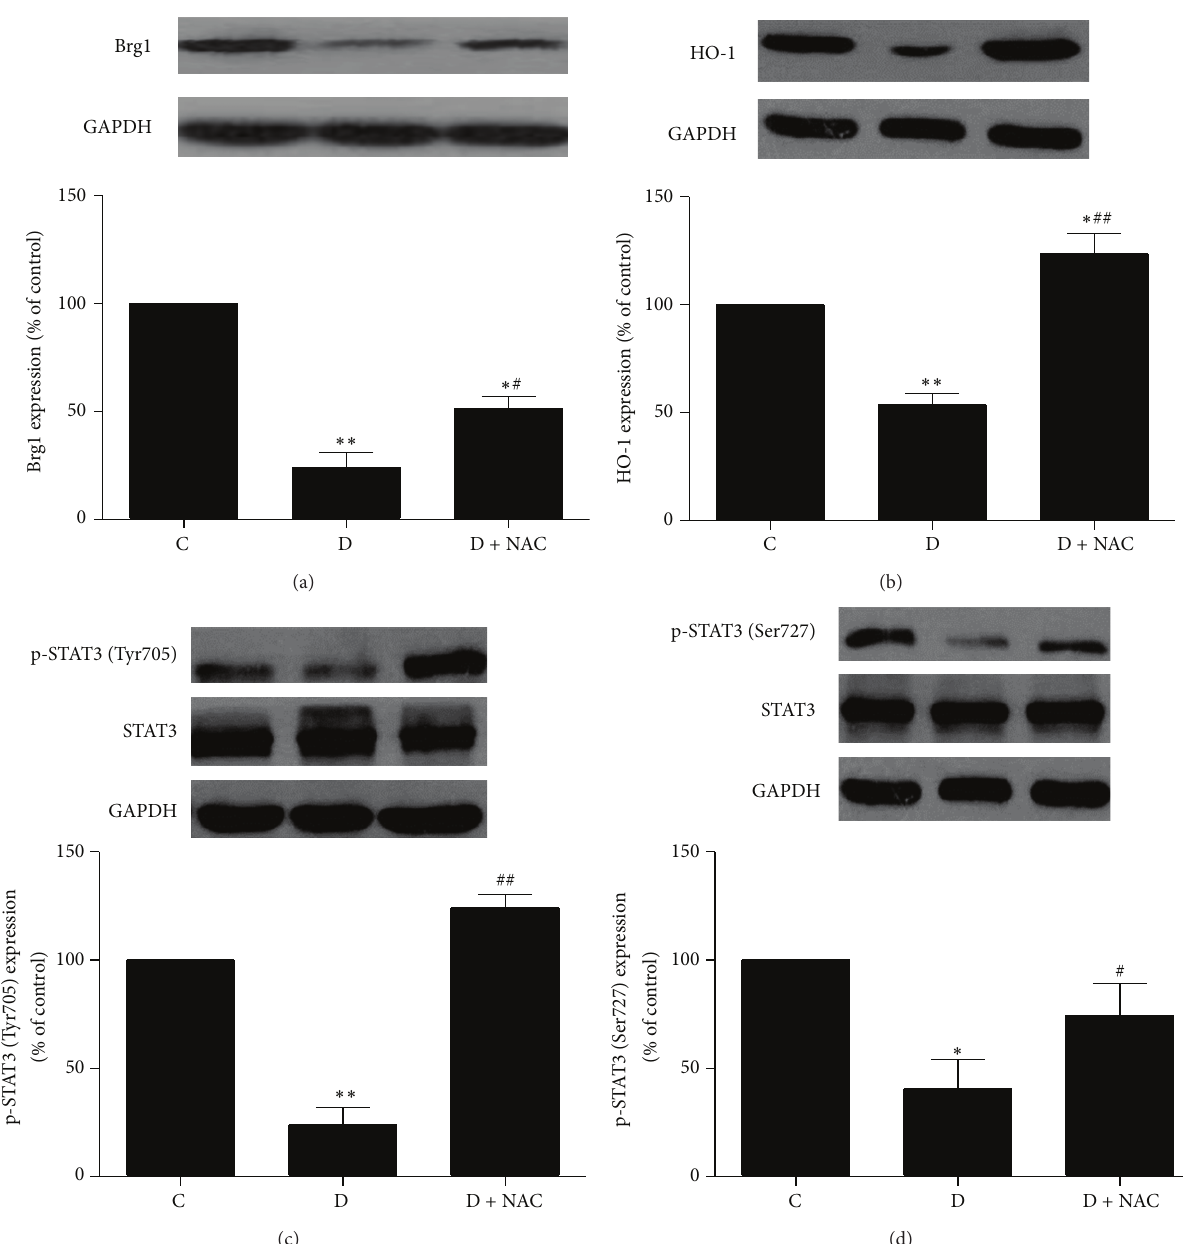
Figure 2: Effects of N-acetylcysteine (NAC) treatment on the protein expression of Brg1 (a), HO-1 (b), and p-STAT3 ((c), (d)) in myocardium. Control (C) or STZ-induced diabetic rats without treatment (D) or with NAC treatment (1.5g/kg/day, D + NAC) for 4 weeks. All values are expressed as mean ± S.E.M. 𝑛 = 6 per group. ∗ 𝑃 < 0.05 , ∗∗ 𝑃 < 0.01 versus C; # 𝑃 < 0.05 , ## 𝑃 < 0.01 versus